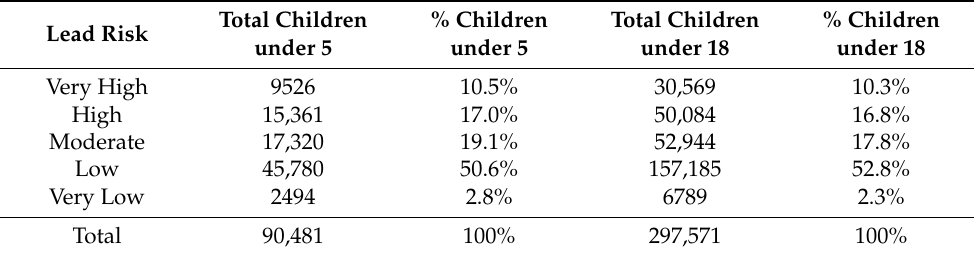
Table 4. Lead risk level and child population in Franklin County, Ohio.